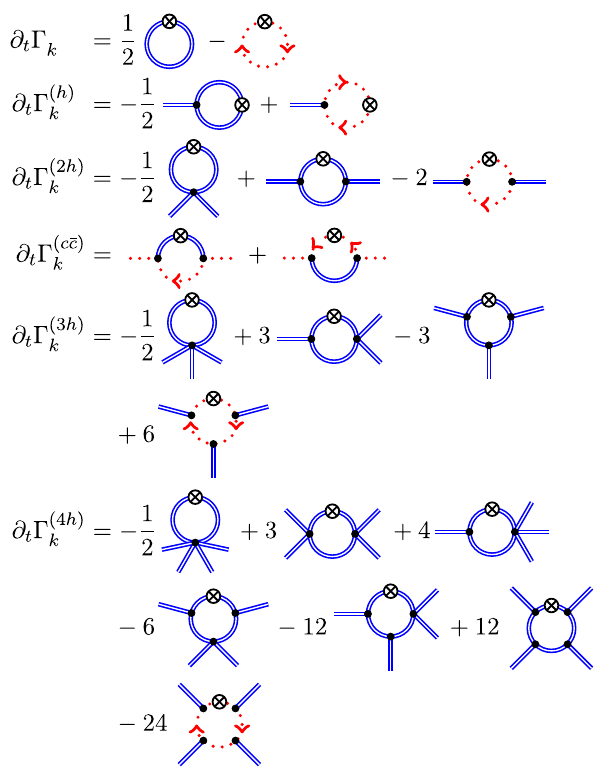
Fig. 1 Diagrammatic representation of the flow of the vertex functions up to the graviton four-point function. The flow of any n -point func- tion depends on the ( n + 1 ) - and ( n + 2 ) -point functions. Double and dotted lines represent graviton and ghost propagators, respectively. All vertices are dressed and denoted by filled circles. Crossed circles stand for regulator insertions. Symmetrisation with respect to interchange of external momenta p i is understood tex. In the above equations, p = ( p φ